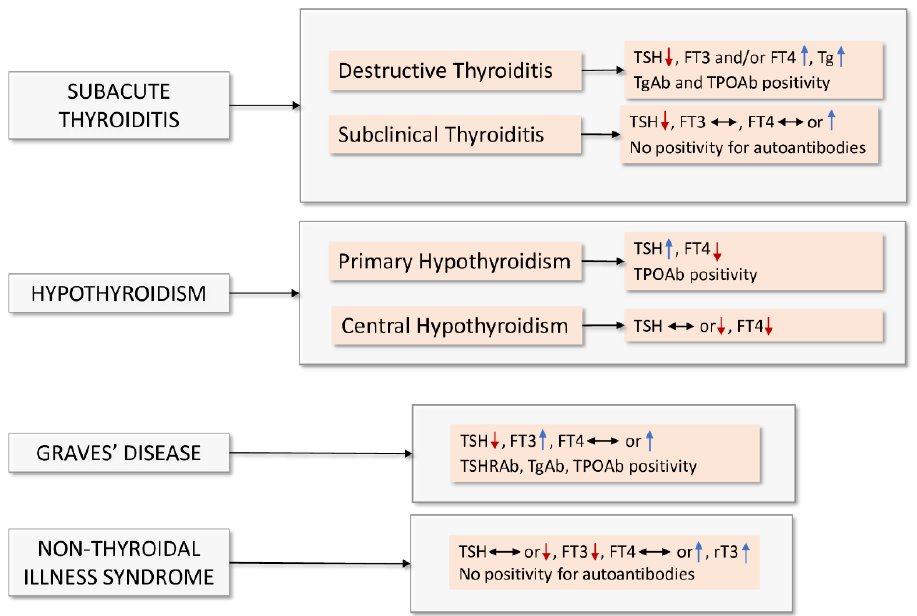
Figure 1. Main features of thyroid diseases potentially involved in SARS-CoV-2 infection. The arrows in the figure represent an increase or decrease in the serum concentration of thyroid parameteres. Abbreviations: FT3 — free triiodothyronine; FT4 — thyroxine; rT3 — reverse triiodothyronine; Tg — thyroglobulin; TgAb — thyroid antithyroglobulin antibody; TPOAb — thyroid peroxidase antibody; TSH — thyroid-stimulating hormone; TSHRAb — autoantibodies against thyroid-stimulating hormone receptor.